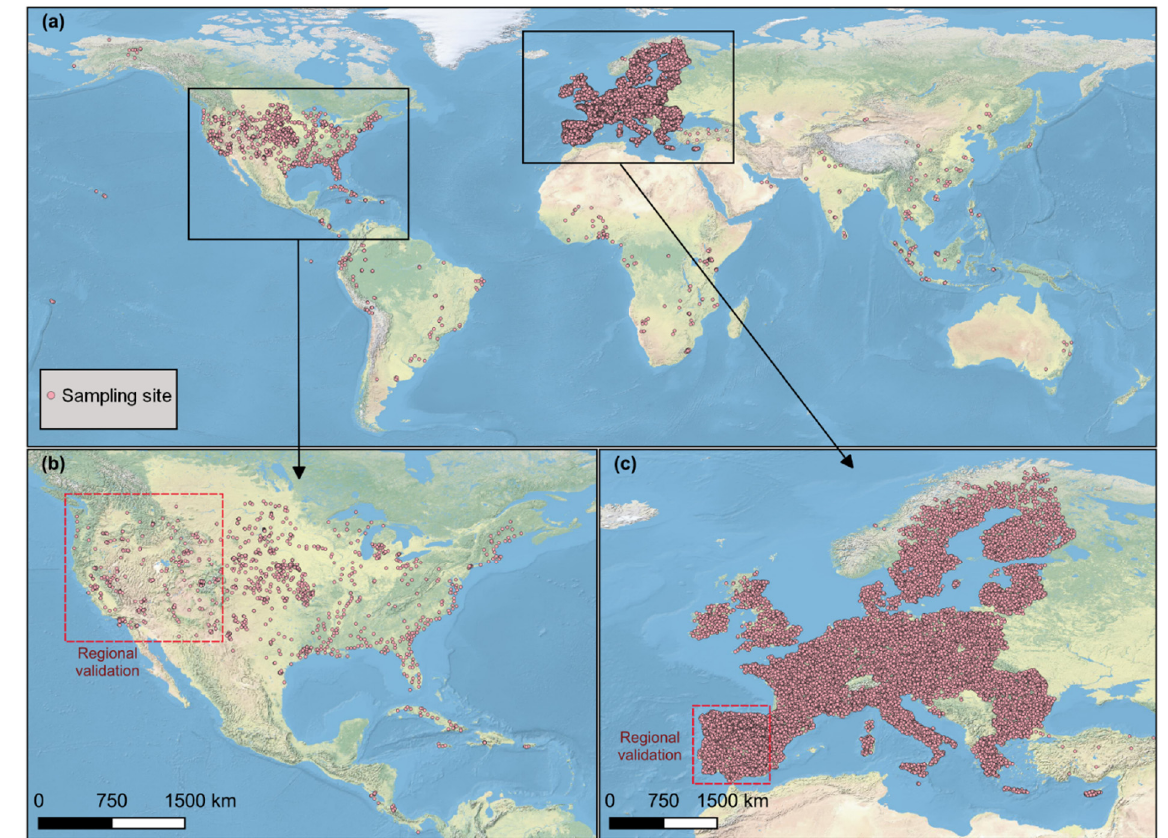
Figure 1. Spatial distribution of soil sampling sites used in this study. ( a ) Two areas for the regional validation are located in the western USA ( b ) and southwestern EU ( c ).